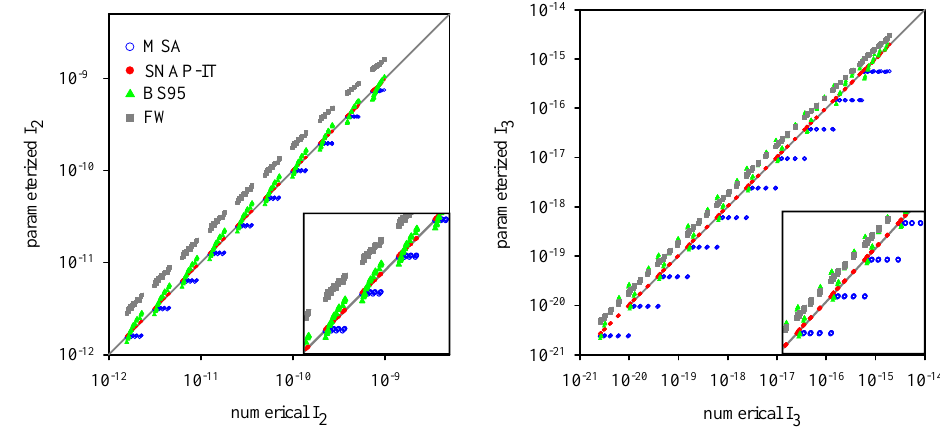
Fig. 6. Comparison of parameterized diffusion growth rates (ordinate) with numerical solutions (abscissa): left: second-moment growth rate I 2 (unit: m 2 particle − 1 s − 1 ); right: third-moment growth rate I 3 (unit: m 3 particle − 1 s − 1 ). MSA is shown as blue open circles, SNAP-IT as red dots, and BS95 as green triangles. Also shown are the numerical solutions using f g from Fukuta and Walter (1970) (grey square, labeled as FW). At the lower right corner of each panel is a close-up of the central section. All rates have been normalized by total number concentration.